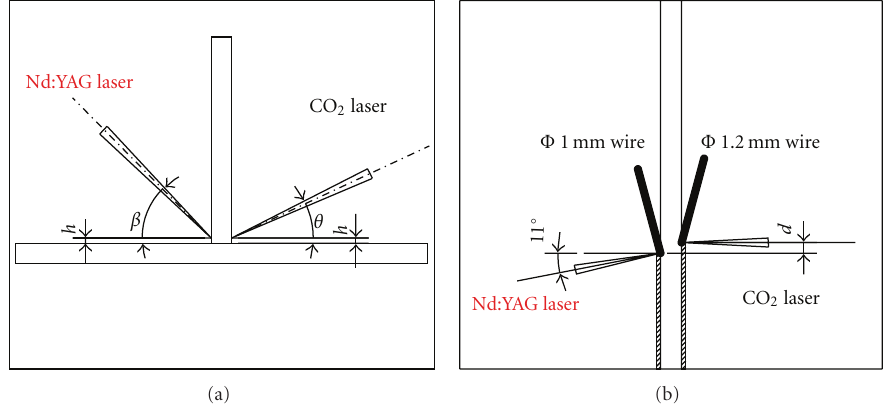
Figure 1: Schematic diagram of the experiment set-up used for the T-joint experiment.